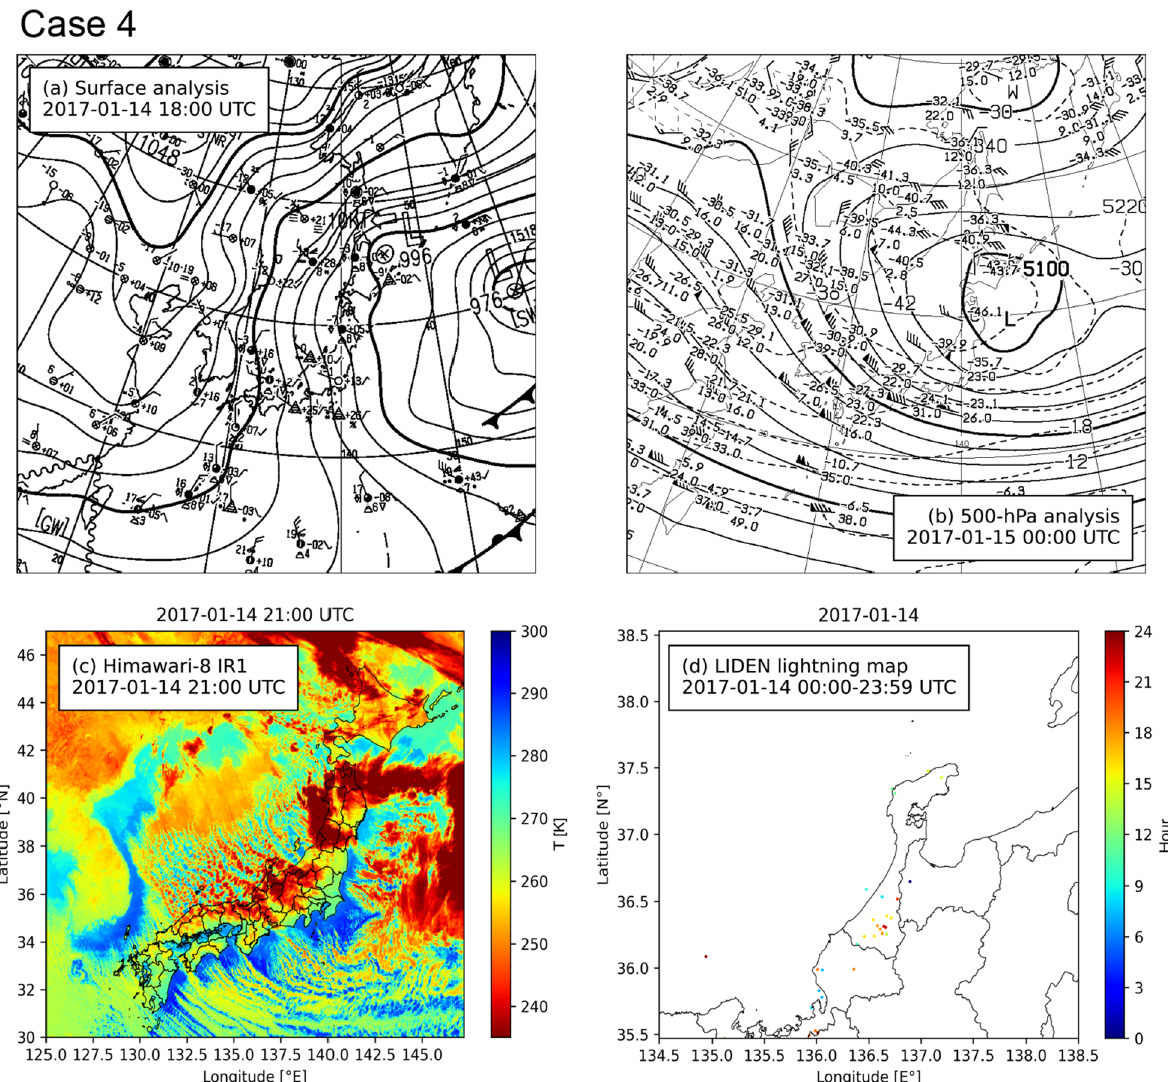
Fig. 10 Meteorological charts of the glow-detection case 4 in the same format as Fig.